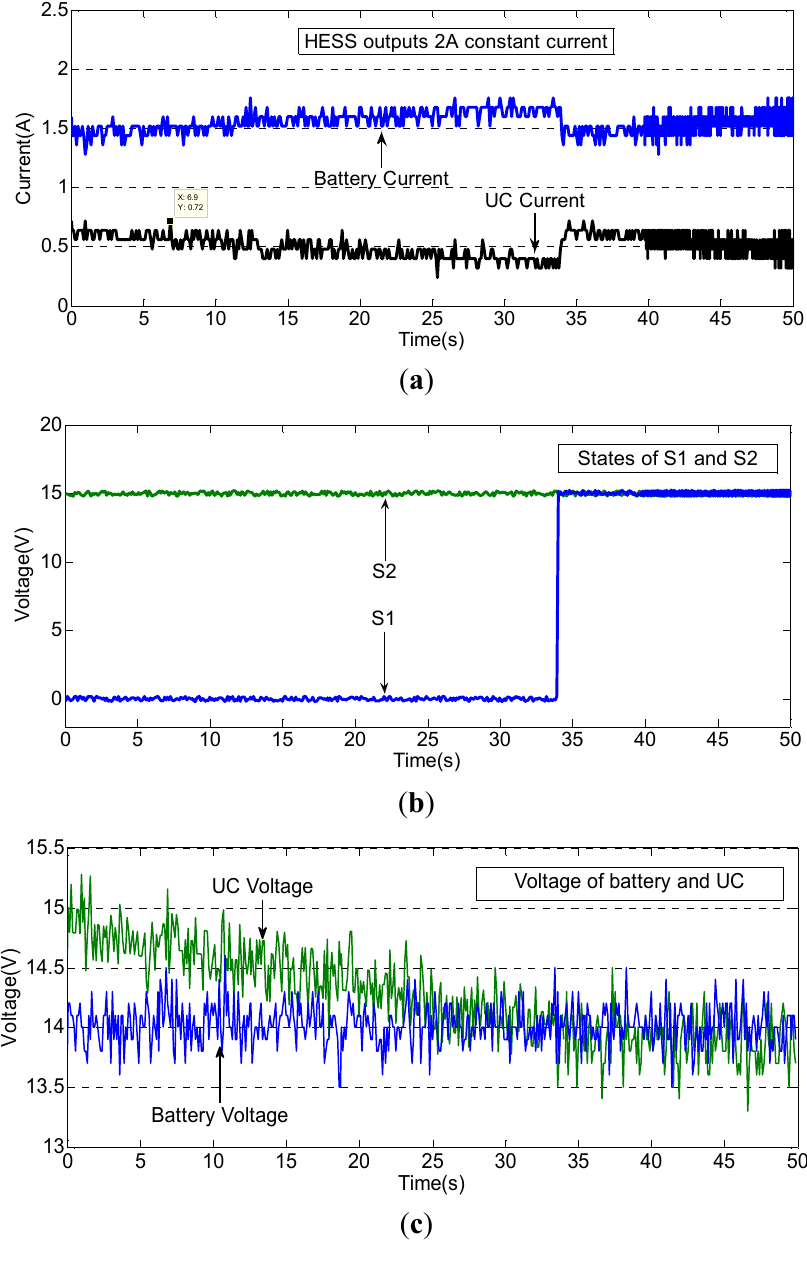
Figure 18. HESS producing a constant 2 A current, initially in Mode II: ( a ) currents from the battery bank and the UC bank; ( b ) states of S1 and S2; ( c ) voltage of the battery bank and UC